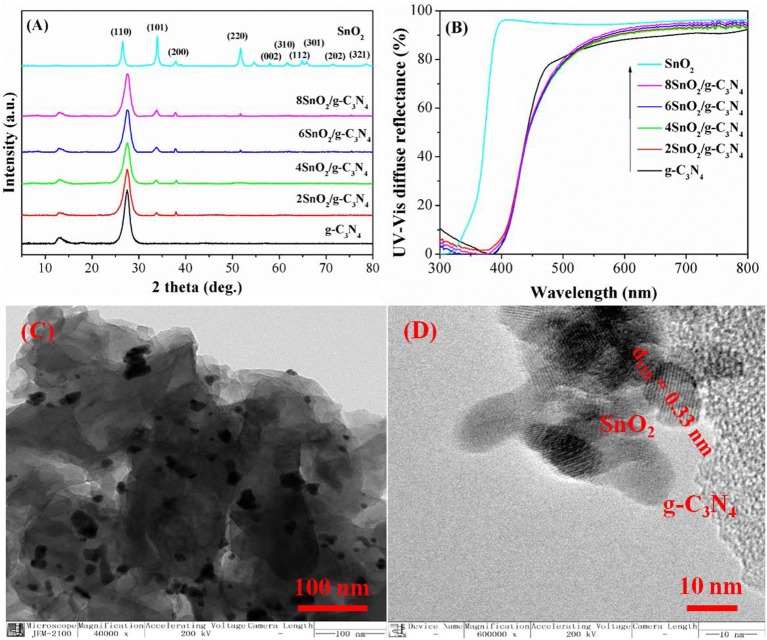
X-ray diffraction (XRD) pattern (A) and diffuse reflectance spectroscopy (DRS) (B) of g-C3N4, SnO2, and XSnO2/g-C3N4. Transmission electron microscope (TEM) image (C) and high-resolution TEM (HRTEM) images (D) of 6SnO2/g-C3N4.